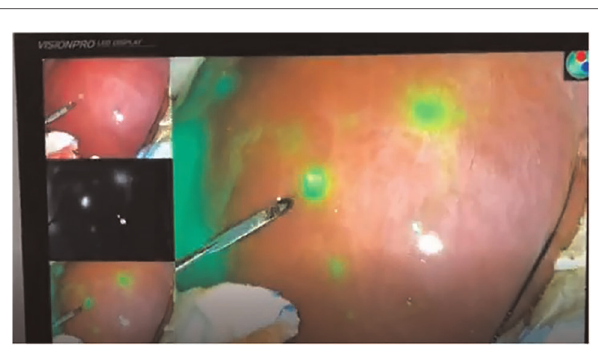
FIGURE 3 | Multiple small lesions were detected by (ICG) fl